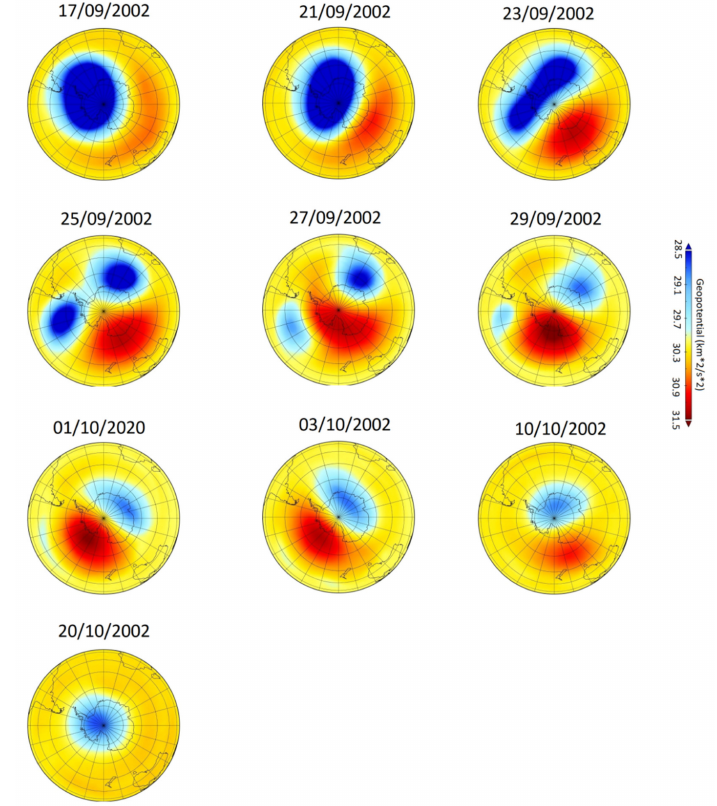
Figure 10. Geopotential heights at 10 hPa during SSW in 2002 in the